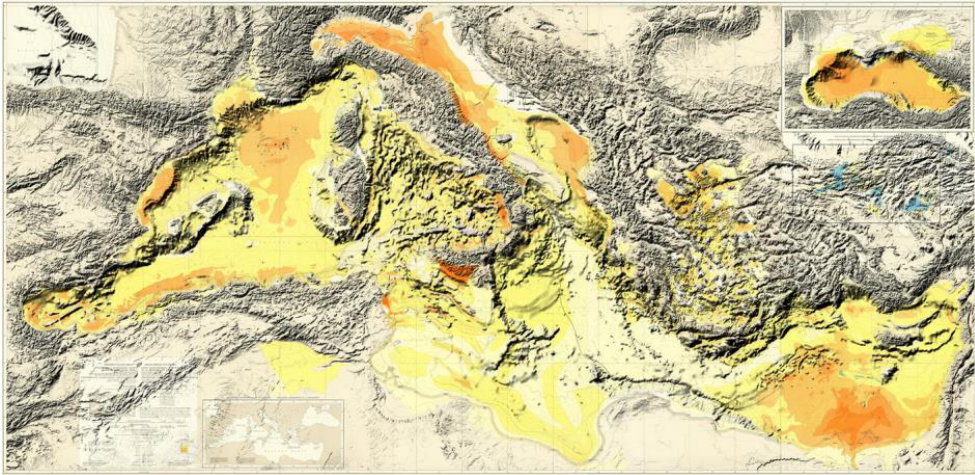
Figure 8. The thickness of the sediments on the seabed of the Mediterranean Sea (adopted from (https://www.ngdc.noaa.gov/mgg/ibcm/ibcmsedt.html (accessed on 1 February 2023)) [67]).